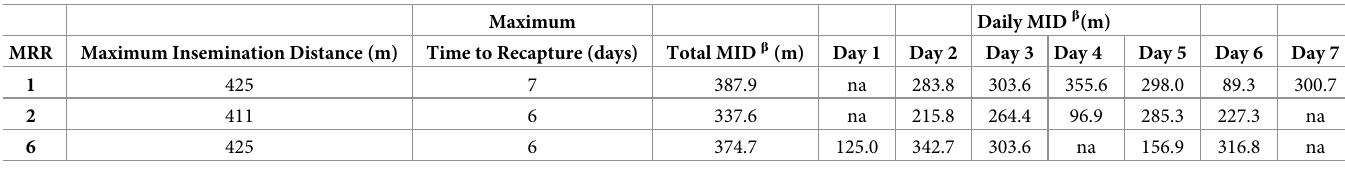
Table 5. Mean Insemination Distances (MID) estimates adapted from traditional annulus-based methods. Estimates give an estimation of the distance at which inseminated females are then captured over time.